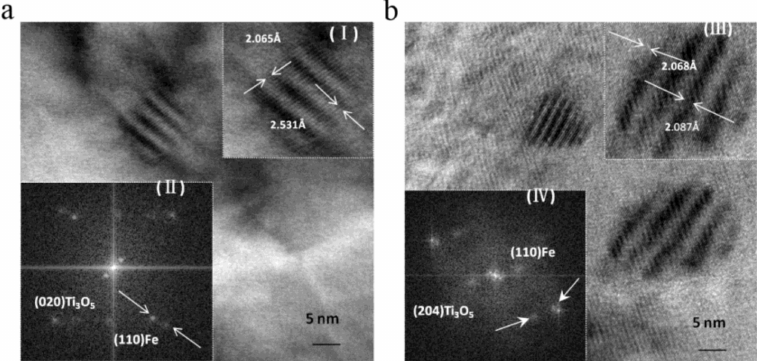
Figure 9. HRTEM micrograph of the nanoparticles in Ni-Cr-Mo-V-Nb-Ti ship steel at ( a ) as-cast and ( b ) 700 ◦ C tempered state, respectively (Demarcate analysis of the SADP are shown in the insets)